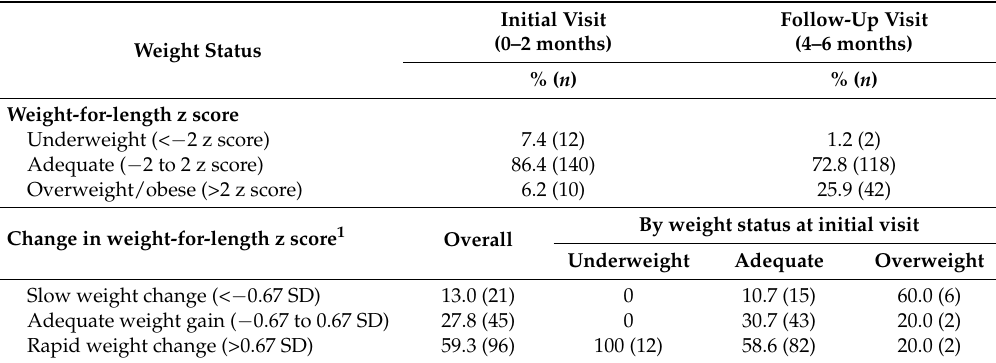
Table 3. Weight status in infants during the study ( N =